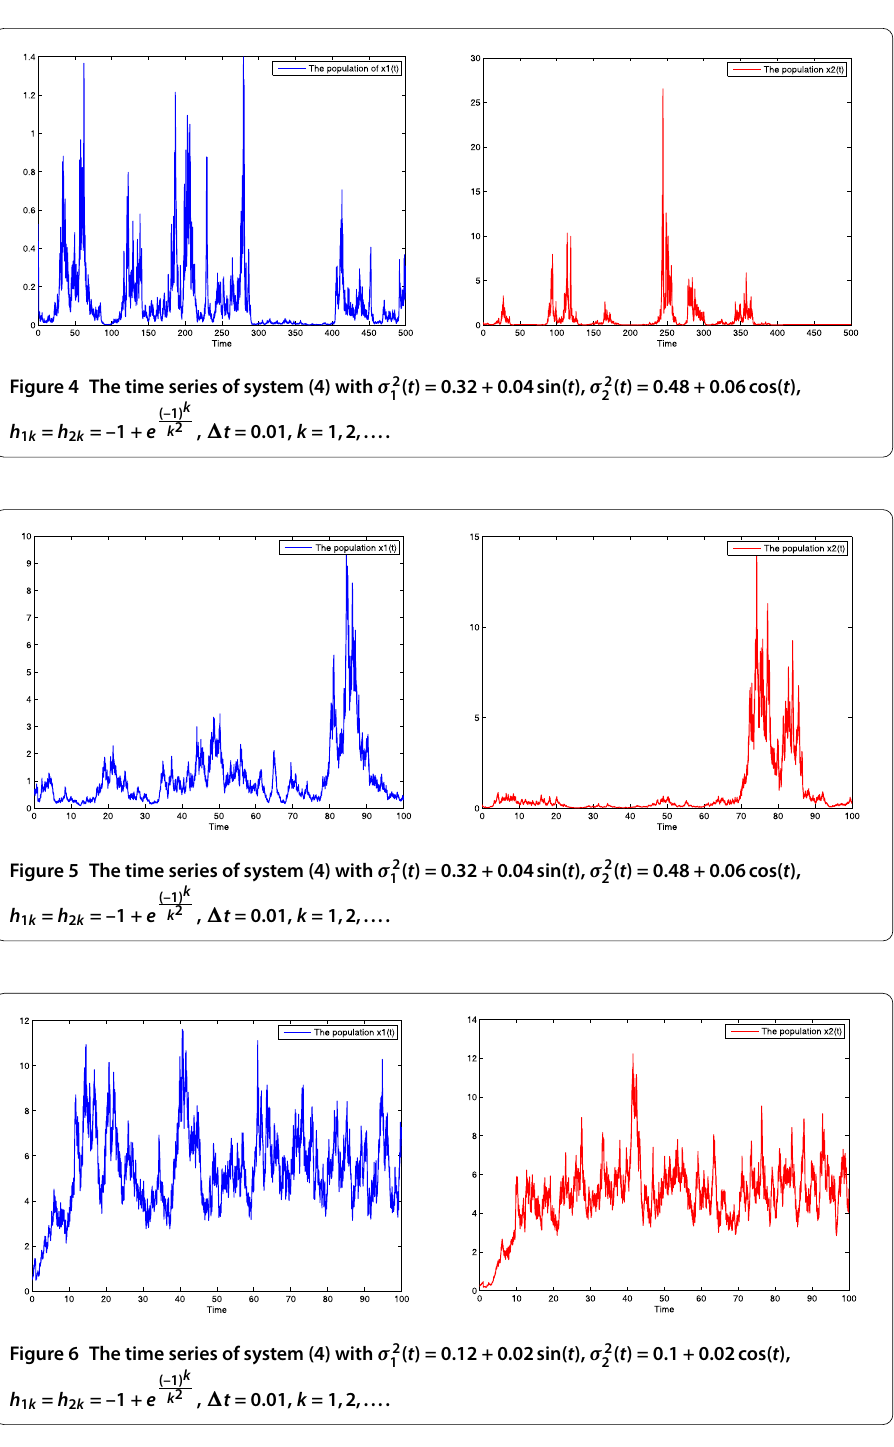
Figure 6 The time series of system (4) with σ 2